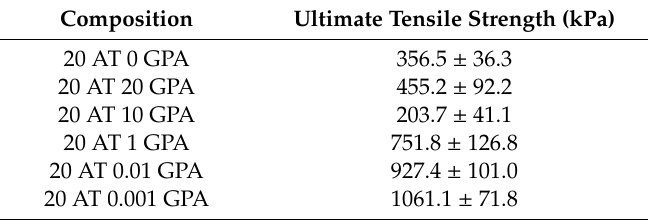
Table 3. Ultimate tensile strength (UTS) for compositions with varied GPA content.